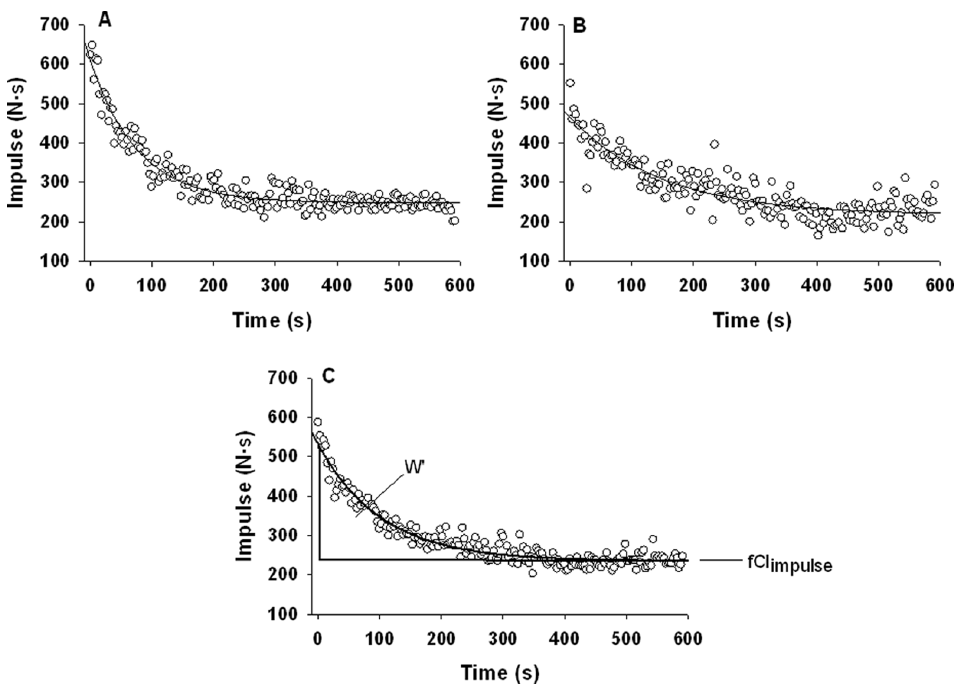
Figure 3. Curve fitting approach to determining fCF impulse and W 9 for a representative subject. Panel A: Test 1 plot of contraction impulses with line of best fit. Panel B: Test 2 plot of contraction impulses with line of best fit. Panel C: Average of Test 1 and Test 2, showing line of best fit, the fCF impulse , and the area between fCF impulse and the line of best fit of the average contraction impulse which is W 9 .